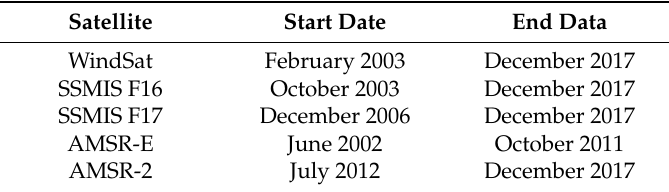
Table 1. Time periods of the selected satellite